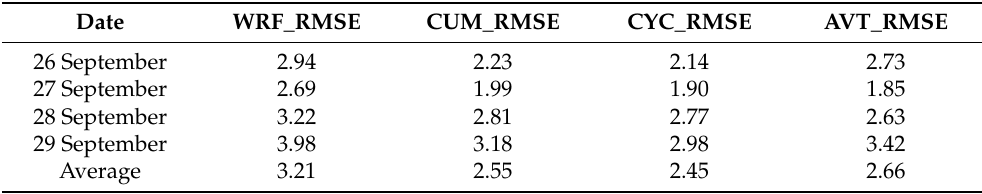
Table 3. Comparison of root mean square error (RMSE) between the simulated wind speed